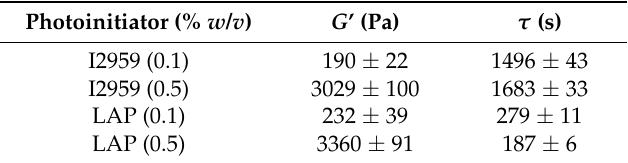
Table 1. Effect of photoinitiator type and concentration on both gelation kinetics and storage modulus obtained of thiol-ene mixture CollPEG3.5 as investigated via time and amplitude sweeps, respectively. Data presented as means ±